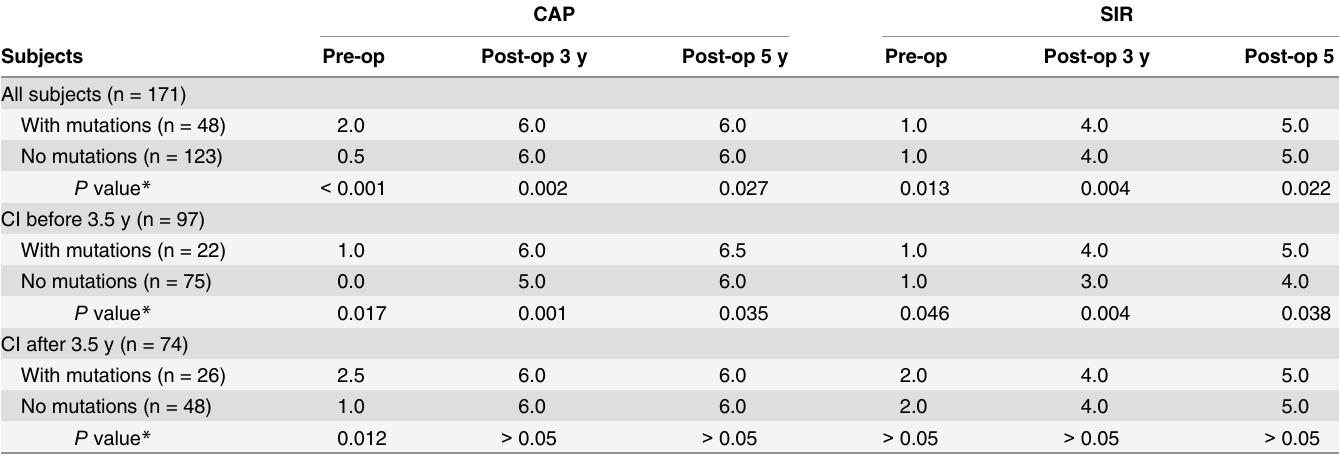
Table 5. CAP and SIR scores in all subjects, subjects implanted before the age of 3.5 years and subjects implanted after 3.5 years. CAP SIR